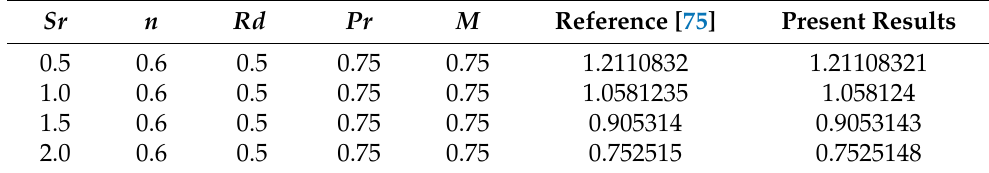
Table 3. Computation of Sh x , for Du = We = 0.